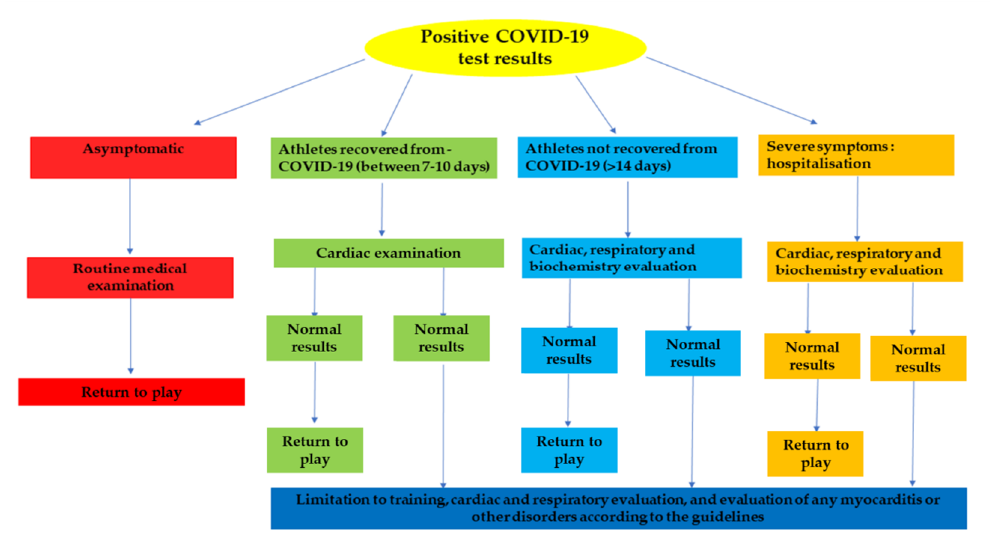
Figure 5. Protocols for return-to-play for the athletes.